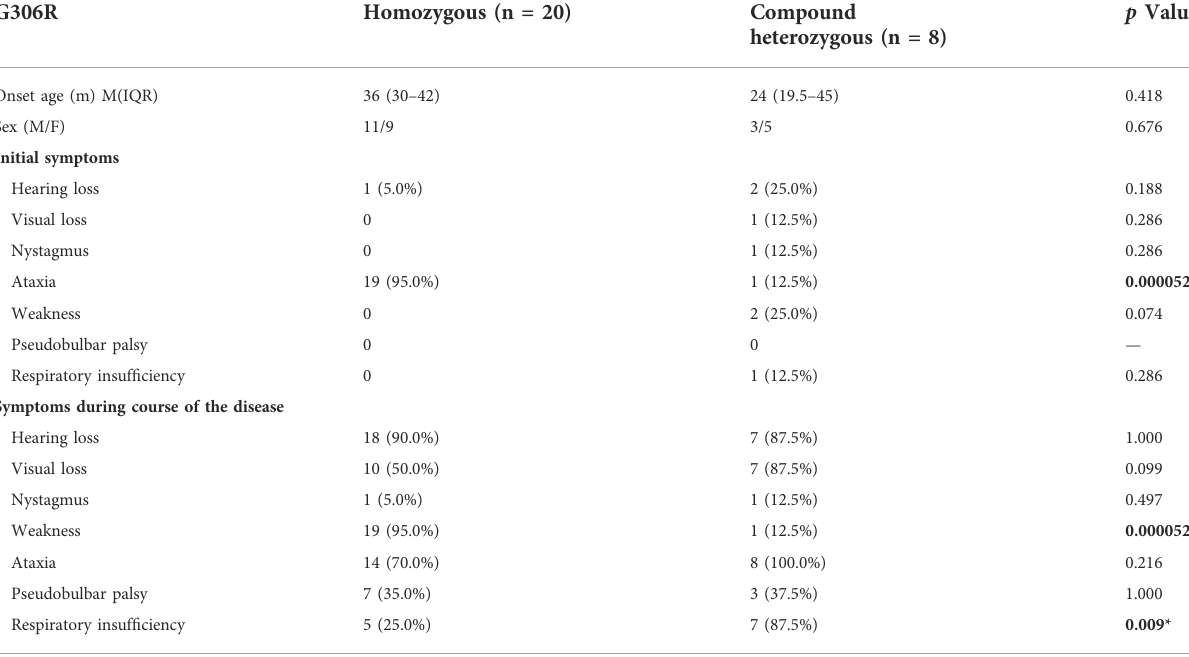
TABLE 4 Comparison of the clinical features between the homozygous G306R mutation and compound heterozygous mutations in the SLC52A2 gene.